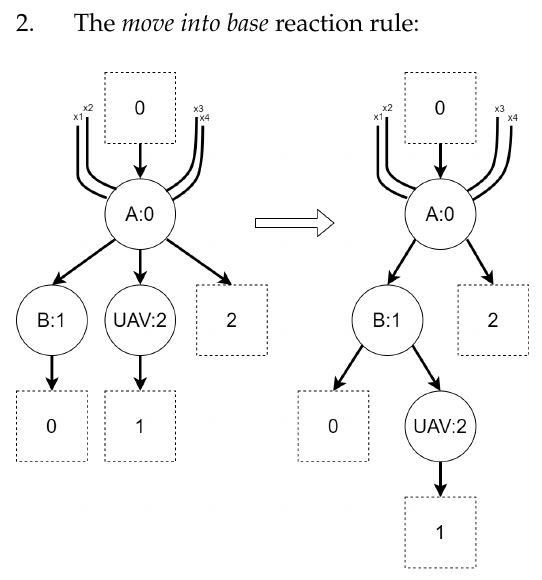
Figure 9. Reaction rule move into base for scenario